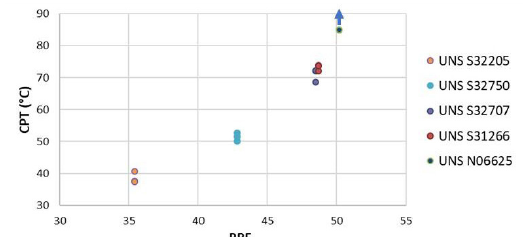
Figure 8. CPTs obtained for UNS S31266